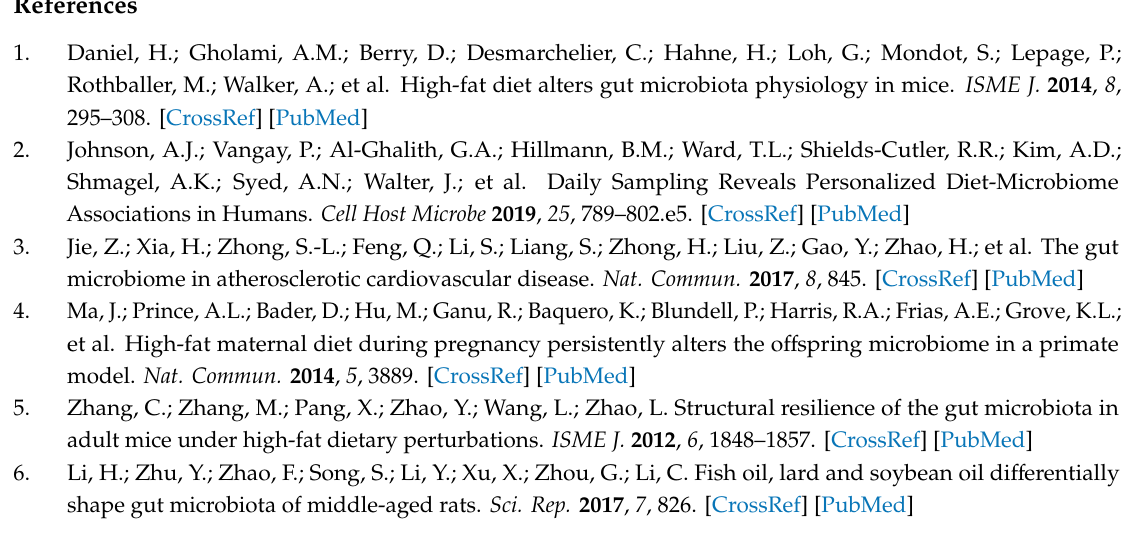
Figure S1: Di ff erently abundant taxa of control mice preceding and following the study period. Figure S2: Relative abundances of inferred gut microbial metabolic pathways of control and SOE treated mice preceding and following the experimental period. Table S1: Average atherosclerosis-related biomarkers used for correlation